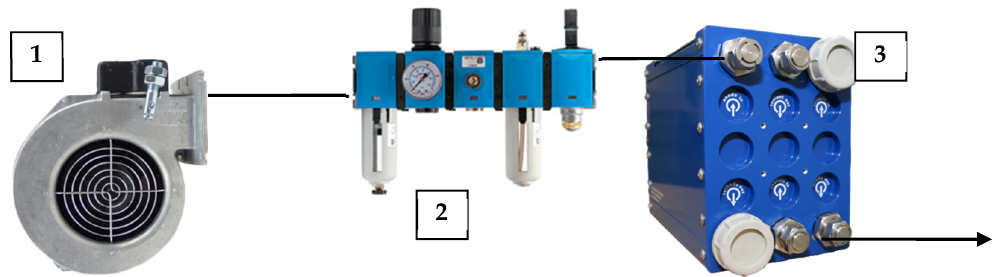
Figure 1. Typical simplified configuration of oxidizer subsystem for proton exchange membrane (PEM) fuel cell stack supplied with atmospheric air: 1, blower or compressor; 2, air preparation block; and 3, PEM fuel cell stack.